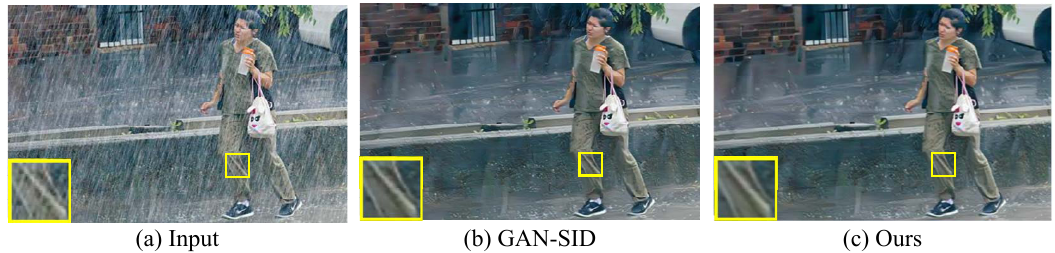
Figure 1. A de-raining example of proposed model on real world